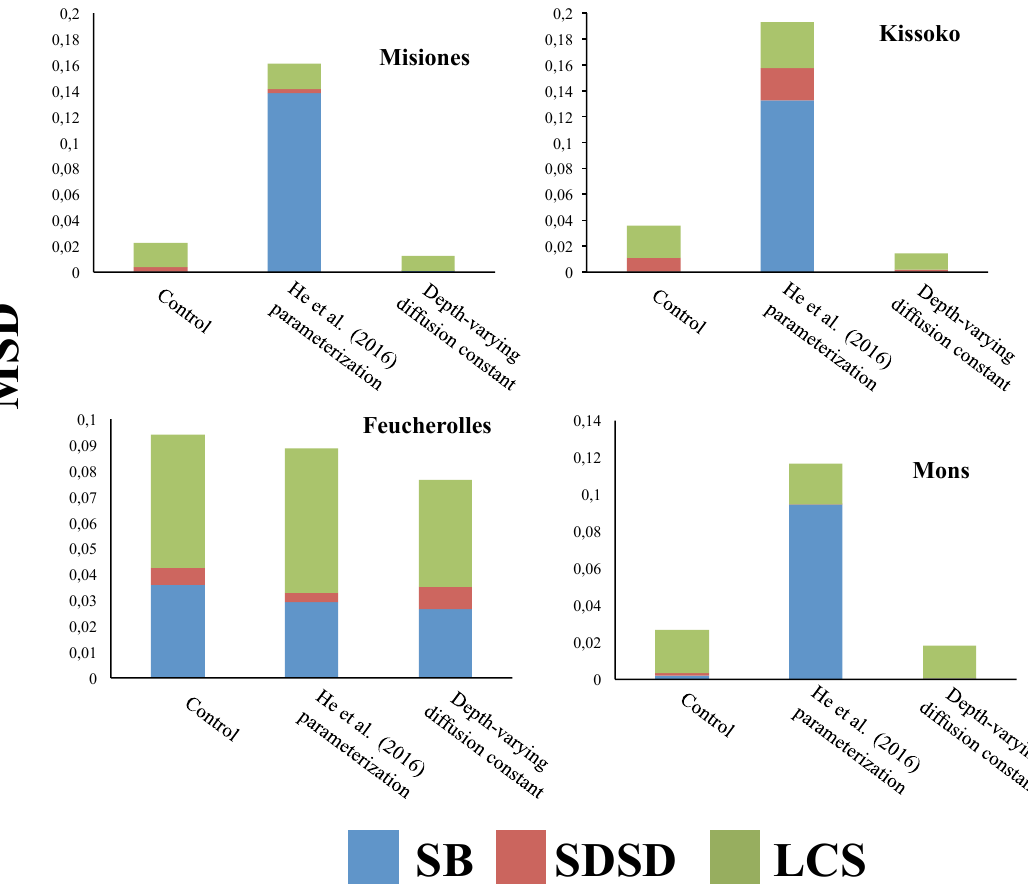
Figure 6. Mean squared deviation (MSD) and its components: lack of correlation weighted by the standard deviation (LCS), squared dif- ference between standard deviations (SDSD) and the squared bias (SB) calculated for modern fraction F 14 C. For the four sites, the results of the initial version of the model ORCHIDEE-SOM- 14 C (Control), those from the version including the modification according to He et al. (2016) (He et al., 2016, parameterization) and diffusion varying according to depth (Depth-varying diffusion constant) are